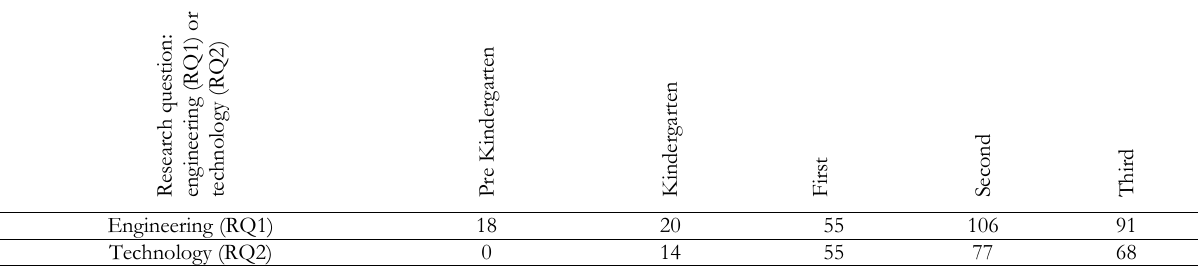
Table 2. Number of students participating at each grade level by research